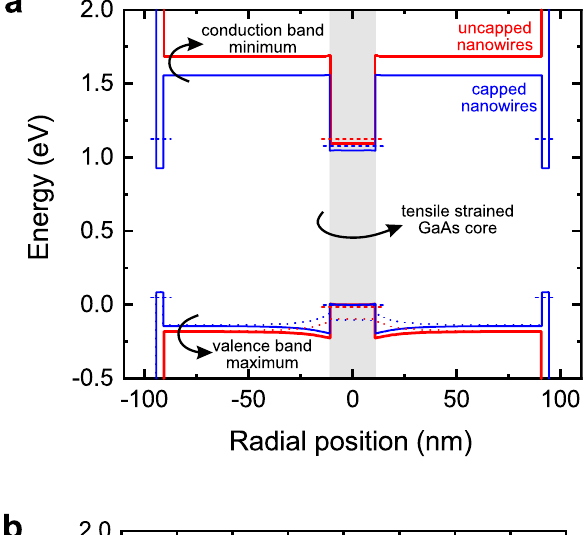
Fig. 2 Simulated electronic structure of the investigated GaAs/ In 0.37 Al 0.63 As core/shell (uncapped) and GaAs/In 0.43 Al 0.57 As/ In 0.44 Ga 0.56 As core/shell/capping-shell (capped) nanowires at 300 K using 8-band k·p theory. a Band-edge pro fi le at the Γ -point of the Brillouin (cid:10) (cid:11) zone, along the 1 (cid:1) 10 crystallographic direction (from the middle of one side-facet, through the centre of the core at zero position, to the middle of the opposite side-facet). The valence bands for heavy and light holes are shown with continuous and dotted lines, respectively. The lowest con fi ned energy levels in the core and the capping shell are indicated with horizontal dashed lines. b Γ -valley energy dispersion in the GaAs core, simulated along the [111] crystallographic orientation. One conduction and two valence bands (heavy and light holes) are shown. Results for unstrained bulk are also shown (black dashed lines) for comparison. The valence band maximum at k [111] = 0 has been set to zero energy. c Simulated dependence of the electron effective mass in the GaAs core on the In- content x of the In x Al 1- x As shell (bottom x-axis) and the corresponding core/shell mis fi t (top x-axis). The data points are calculated values, which have been linearly fi